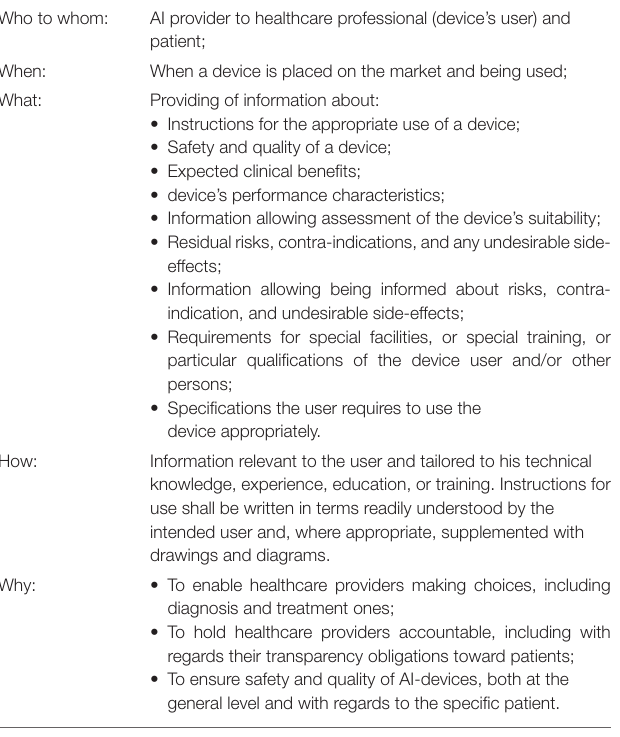
TABLE 2 | Summary of the Medical Devices Framework (illustrated by the MDR) requirements relevant to AI’ internal transparency measures. Who to